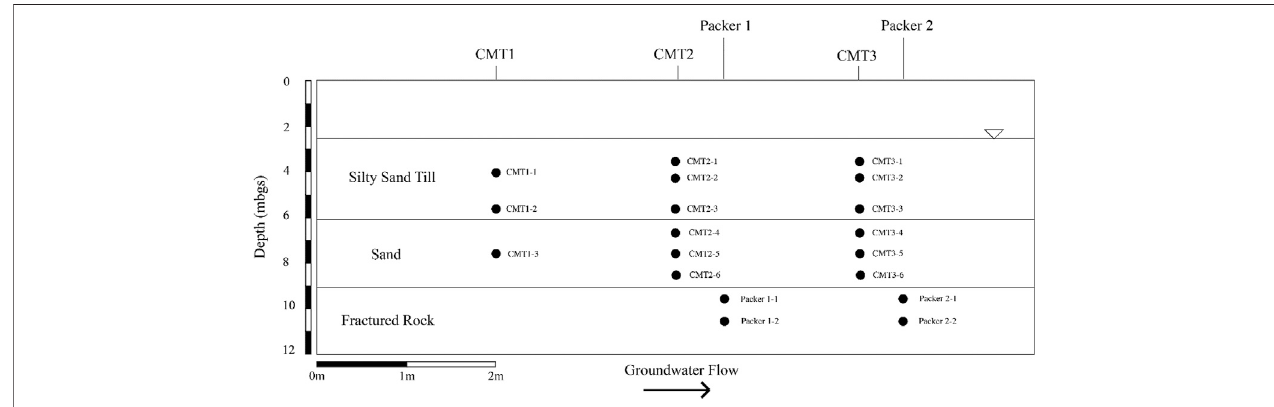
FIGURE 1 | Cross sectional view of test area showing monitoring